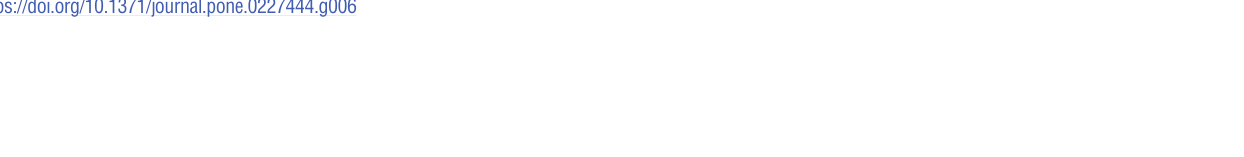
PLOS ONE | https://doi.org/10.1371/journal.pone.0227444 January 29,